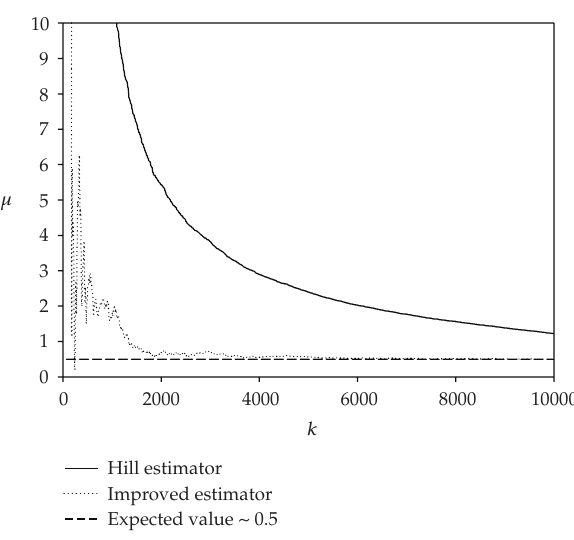
√ Figure 4: A 1 / x behavior (cid:5) see Example 17 (cid:6)